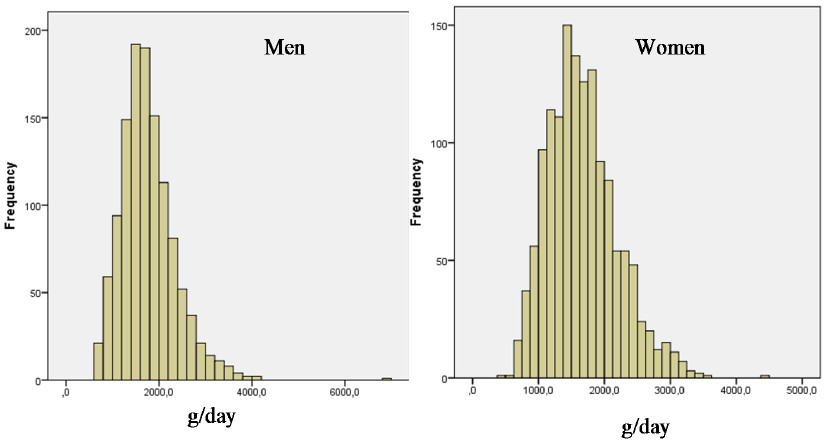
Figure 1. Frequency distribution of total water intake (g/day) over 3 days, by gender.